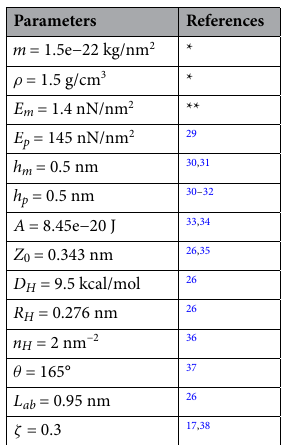
Table 1. Parameters. *Calculated from company specifications. **Experimentally measured by the